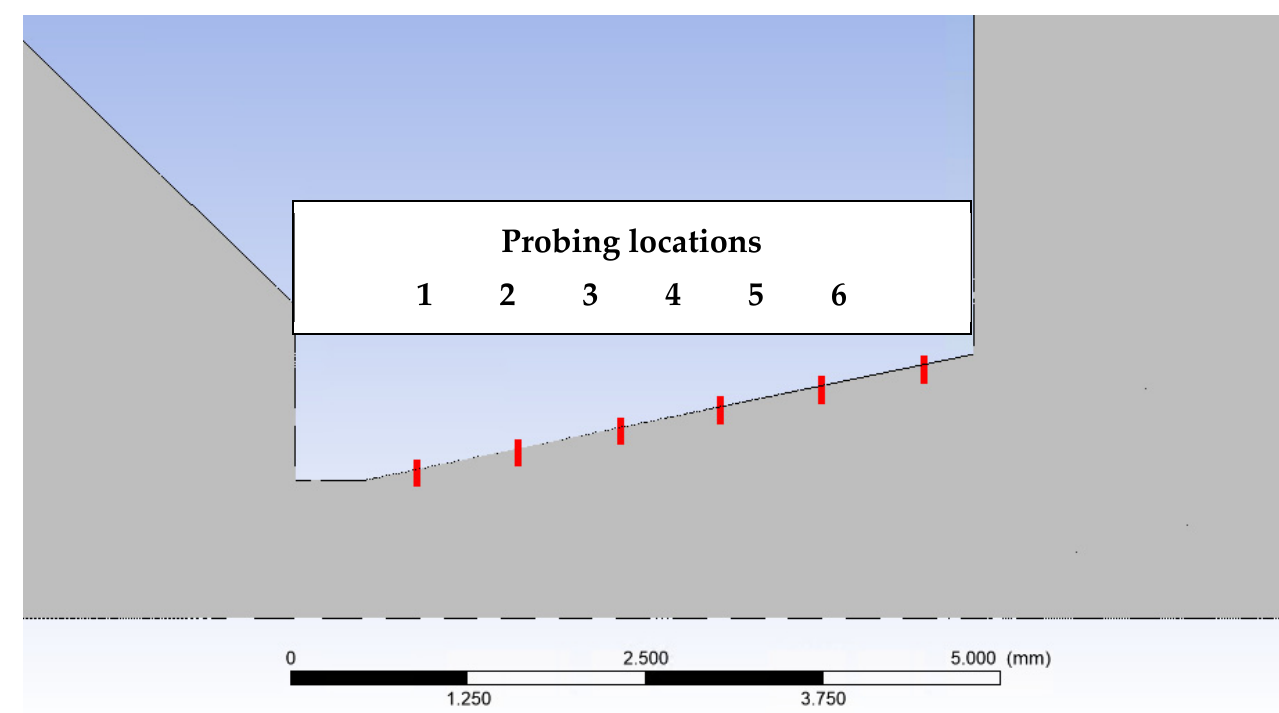
Figure 27. Static pressure distribution on the nozzle wall in the experimental chamber.